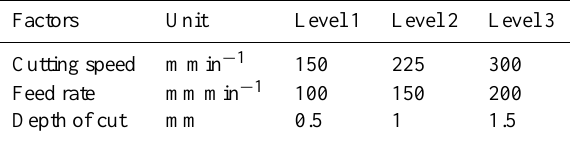
Table 3. Parameters and levels of test.